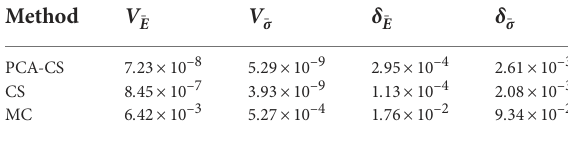
TABLE 4 Relative errors of three methods with 30 sample